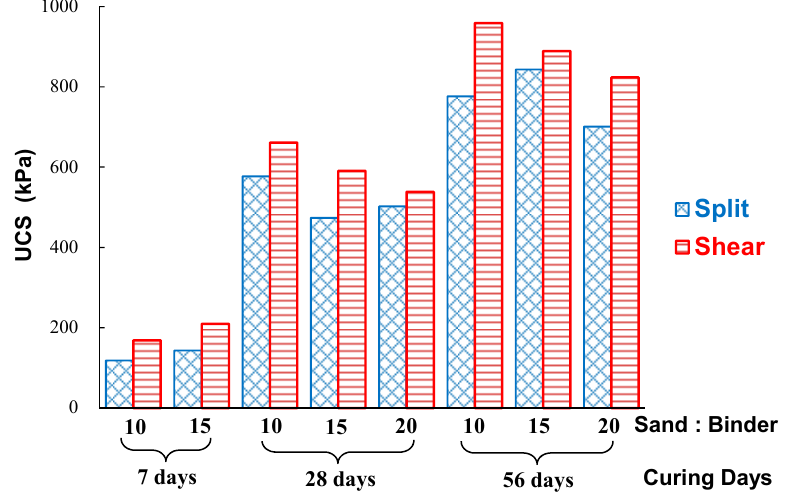
Figure 8. Variation of the averaged UCS values of the cemented hydraulic backfill having a pulp density of 72%, obtained by axially loading the cylindrical samples to failure by diagonal shear and axial split, respectively, with different sand to binder ratios at different curing times.